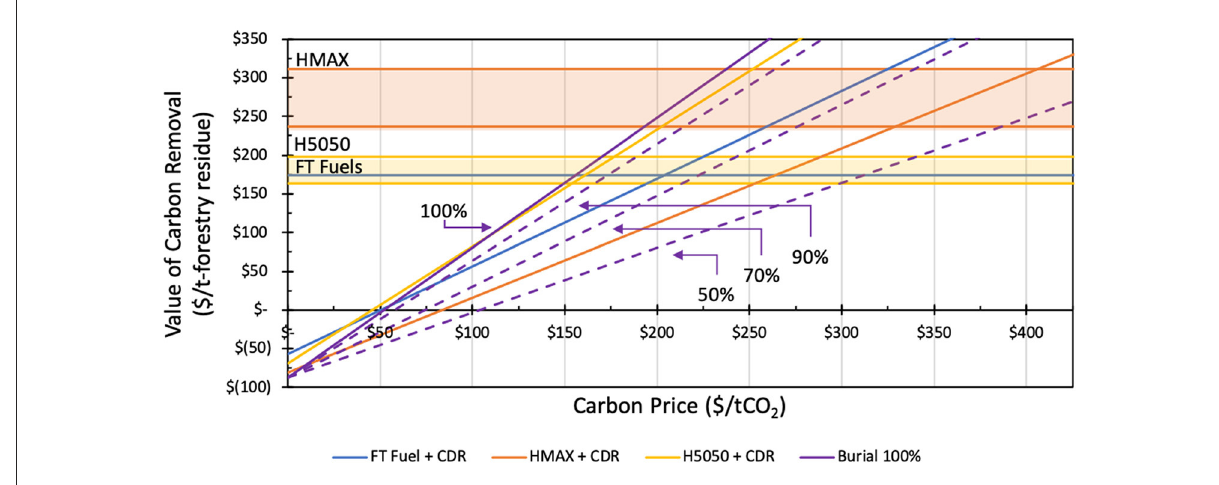
FIGURE5 Sensitivity of the carbon-related revenue stream of biomass burial to its carbon removal efficiency, which is varied from 50 to